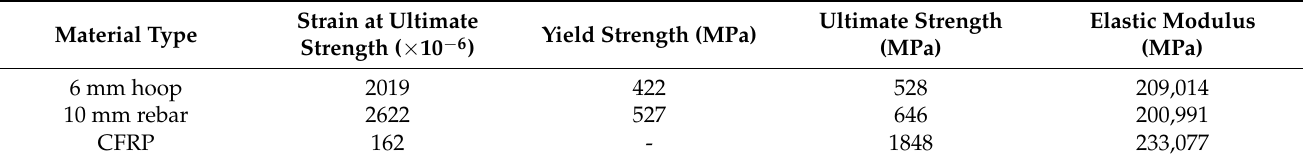
Table 1. Mechanical properties of the reinforcement and